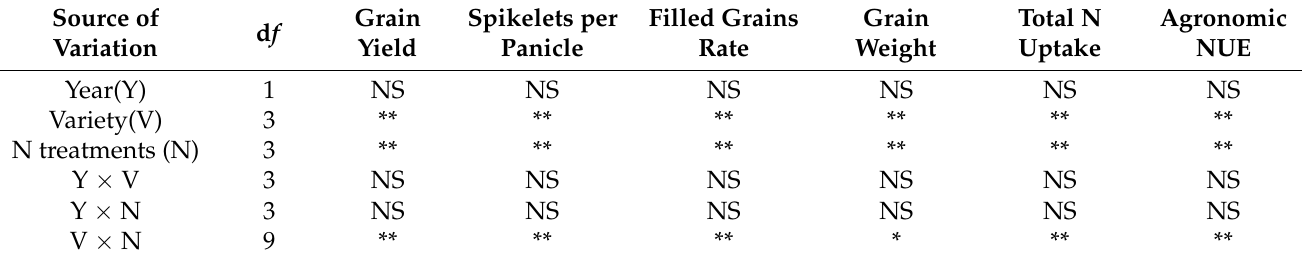
Table 3. Analysis of variance for grain yield, yield components, total N uptake, and agronomic N-use efficiency of rice among varieties for N